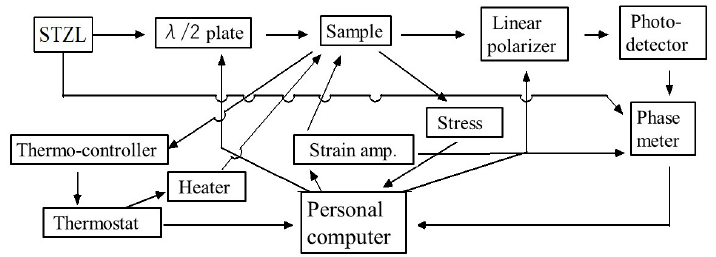
Scheme A2. Photoelasticity measurement